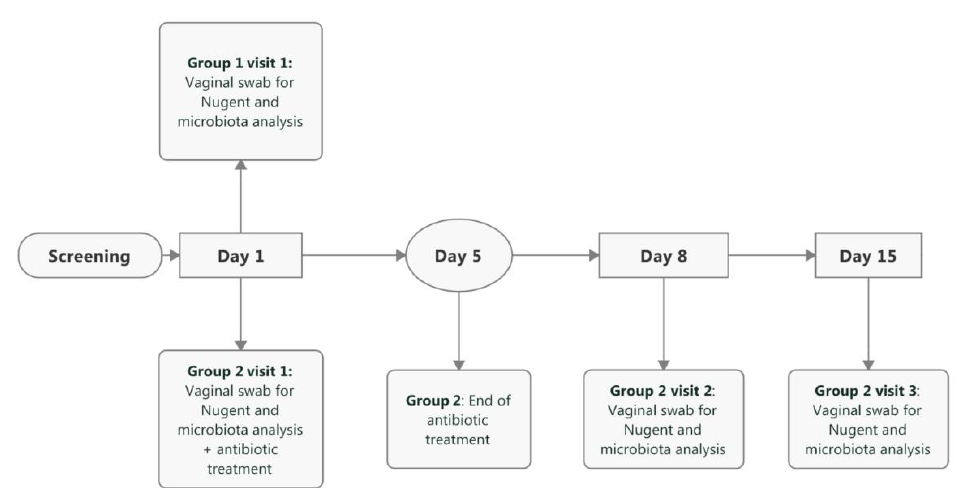
Figure 2. Timeline and schedule of events in the study. Baseline visit for both study groups is referred